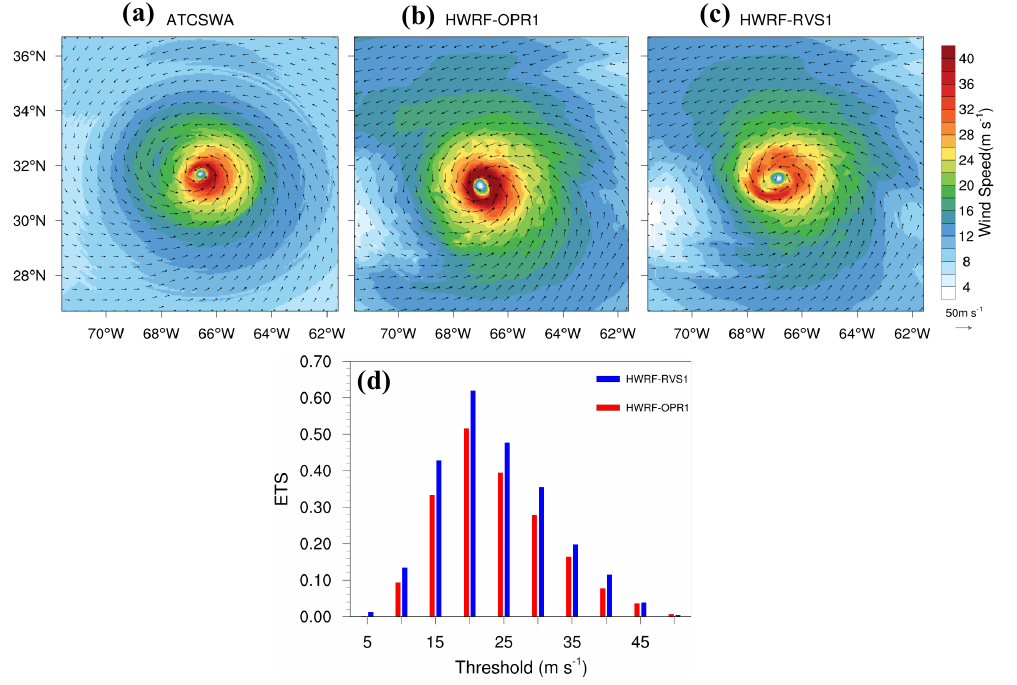
Figure 10. Vortex structure of Hurricane Joaquin at 1800 UTC 04 October 2015 as revealed by wind speeds (shaded; unit: m s − 1 ) and vectors at 10 m height from ( a ) ATCSWA, ( b ) HWRF-OPR and ( c ) HWRF-RVS1. ( d ) the mean equitable threat score (ETS) of the 10-m forecasted wind field from HWRF-OPR1 (red bars) and HWRF-RVS1 (blue bars) compared against the 10-m wind analysis from ATCSWA with thresholds of 5, 10, 15, 20, 25, 30, 35, 40, 45 and 50 m s − 1 . The mean ETS is calculated during the rapid weakening of Hurricane Joaquin from 1800 UTC 03 to 0000 UTC 05 October 2015 with a 6-h